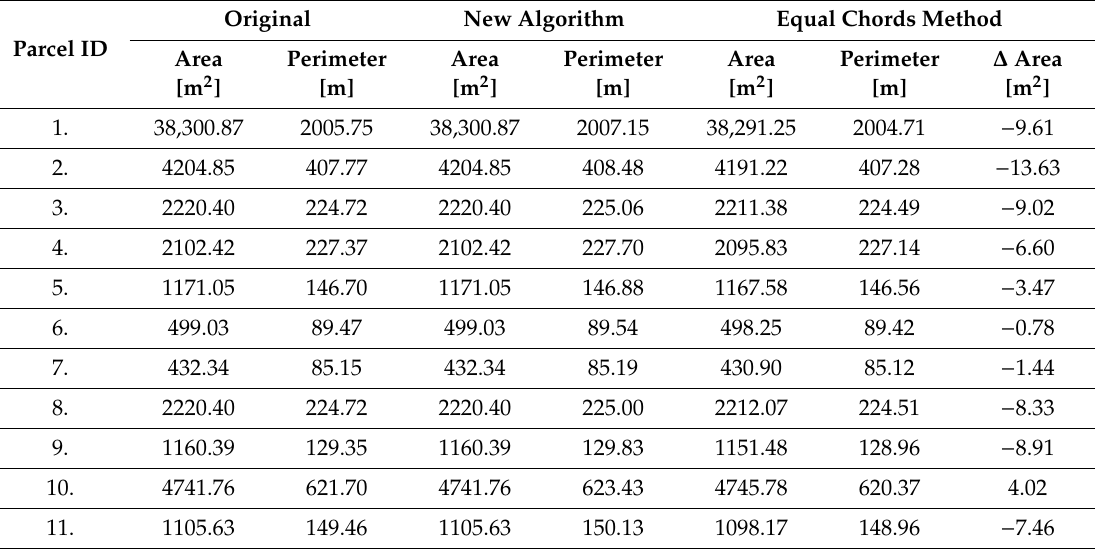
Table 2. Area summary for two methods ( ∆ Area—area di ff erence for the method of chords).